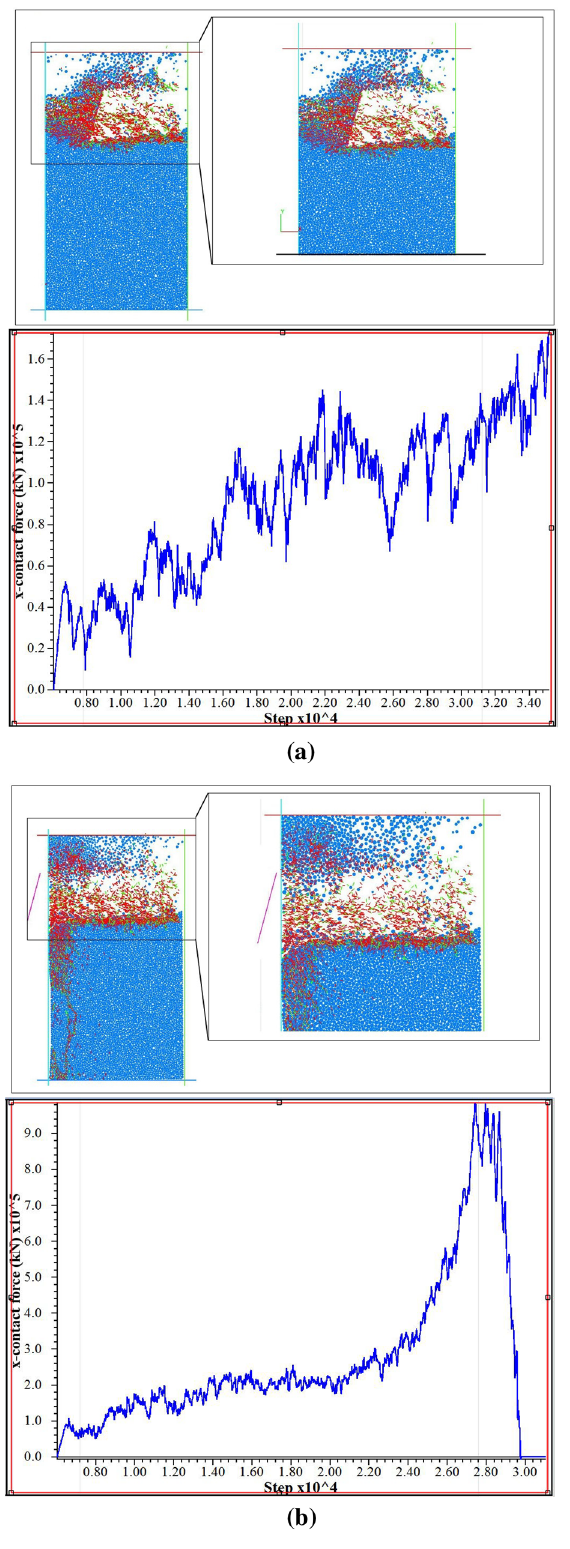
Fig. 17 Results of plow model with zero-degree angle: a Model 21, b Model 22 Fig. 18 Results of plow model with zero-degree angle: a Model 23, b Model